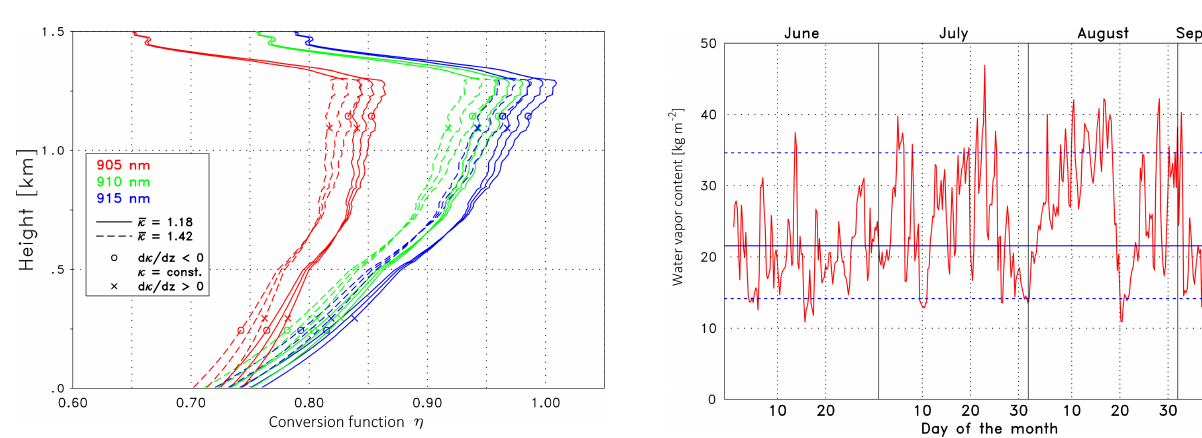
Figure 6. Conversion function η at 905nm (red), 910nm (green) and 915nm (blue) for Case A. Same as Fig. 5 but with idealized height-dependent κ(z) . The solid lines are for a mean Angström ex- ponent of κ as indicated. The three lines grouping together refer to different κ(z) profiles: κ(z) decreasing and increasing with height is marked with a circle and cross, respectively, with the remaining curve showing the constant κ (height independent); see text for de- tails.